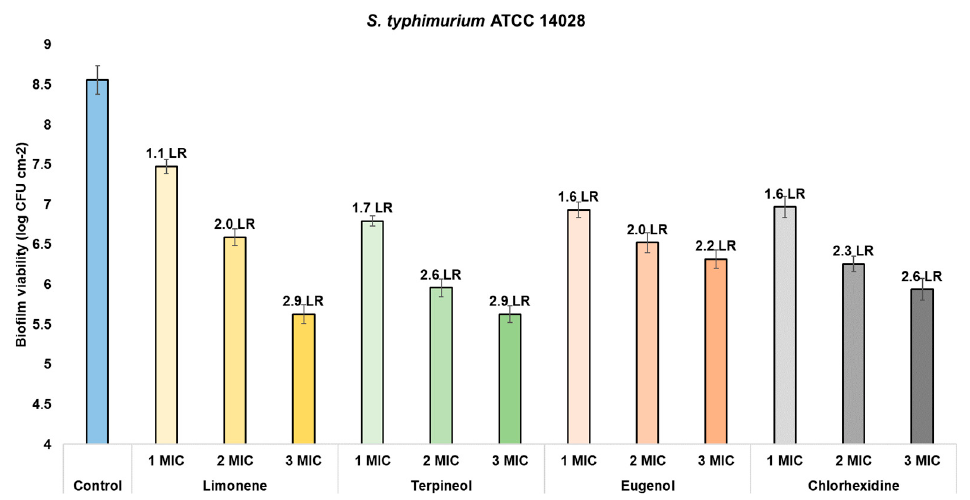
Figure 3. Biofilm viability (log CFU cm − 2 and LR) of E. coli, S. aureus and S. typhimurium after expo- sure to 1 MIC, 2 MIC and 3 MIC limonene, terpineol, eugenol and chlorhexidine.